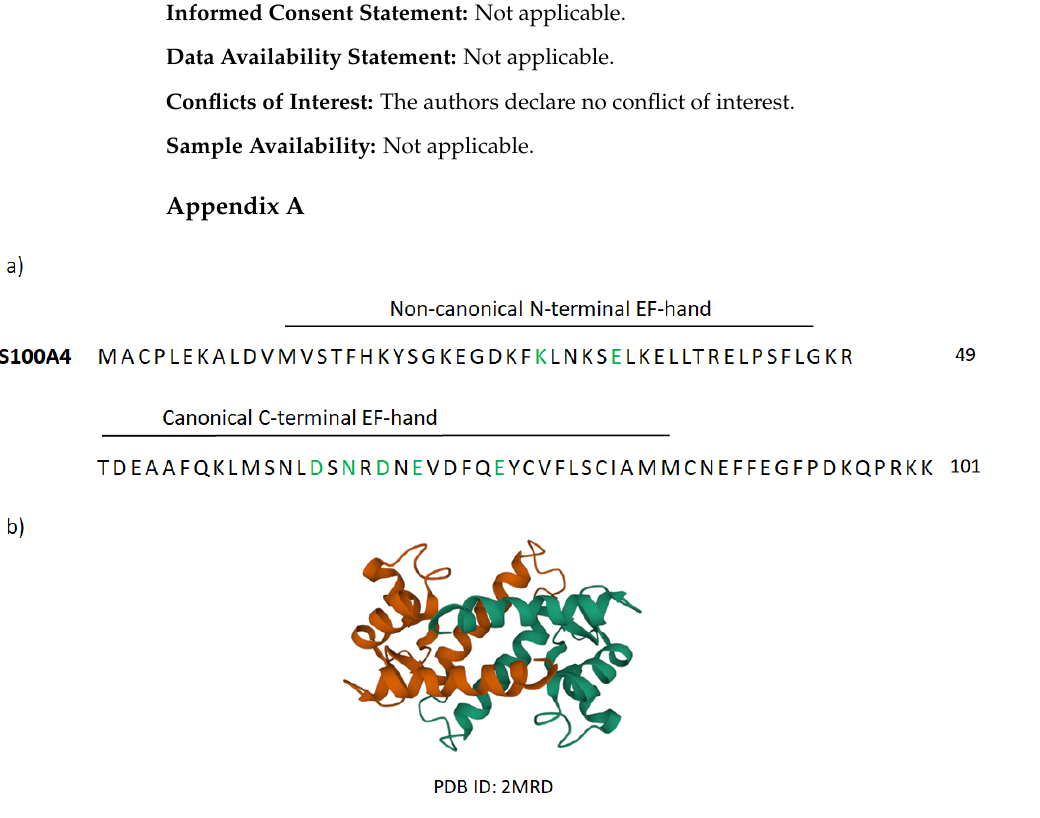
Figure A1. Structures of S100A4 protein: ( a ) predicted amino acid sequence of the human S100A4 (the green color marks the amino acids that bind Ca 2+ ); ( b ) structure of human Ca 2+ -loaded S100A4 cys-free mutant—image from the RCSB PDB (rcsb.org) of PDB ID 2MRD [271].